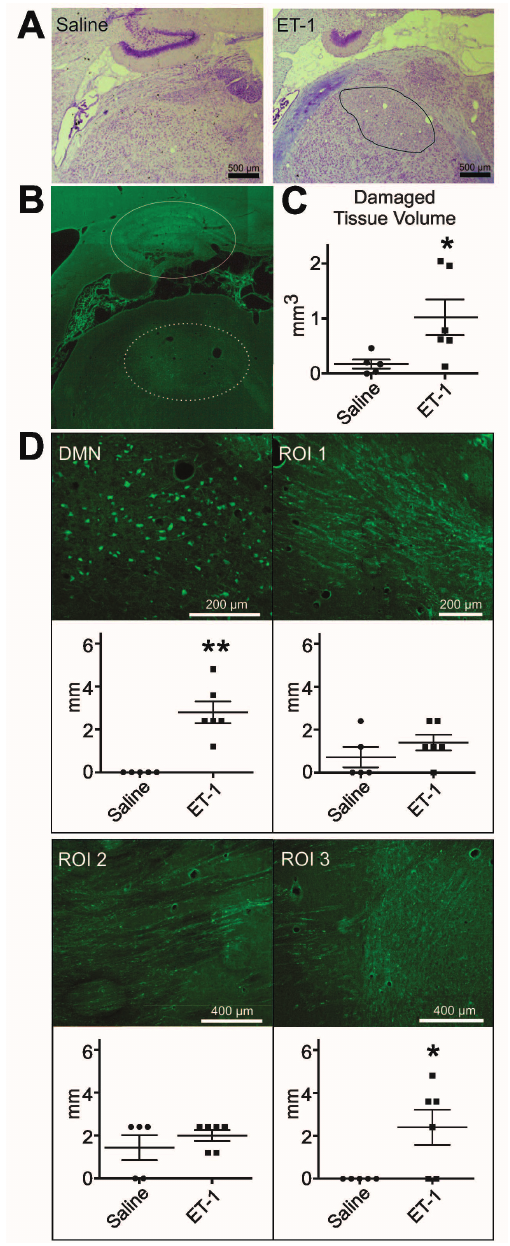
Figure 4. Degeneration in the injected region and along the thalamocortical pathway. ( A ) Thionine staining shows intact control DMN and tissue damage (delineated in black) in the DMN of an ET-1 injected brain; ( B ) FluoroJade B (FJB) positive signal in an image collage created from a sagittal section marks the region of ET-1 injection in the dorsal medial thalamic nucleus (DMN, dashed oval). The hippocampal formation is visible dorsal to the injection site (solid oval), rostral is to the left; ( C ) The area of damaged tissue in the injected region, as defined by FJB positive cells, is significantly greater in ET-1 injected brains than in their saline injected counterparts (Mann Whitney, * p = 0.03); and ( D ) Representative images show FJB positive signal in the DMN and the respective ROIs along the thalamocortical pathway. The lateral extent of FJB positive cells is significantly larger in the DMN (Mann-Whitney, ** p = 0.005) and the frontal cortex (ROI 3, Mann Whiteney, * p = 0.04) of ET-1 injected animals compared to saline injected